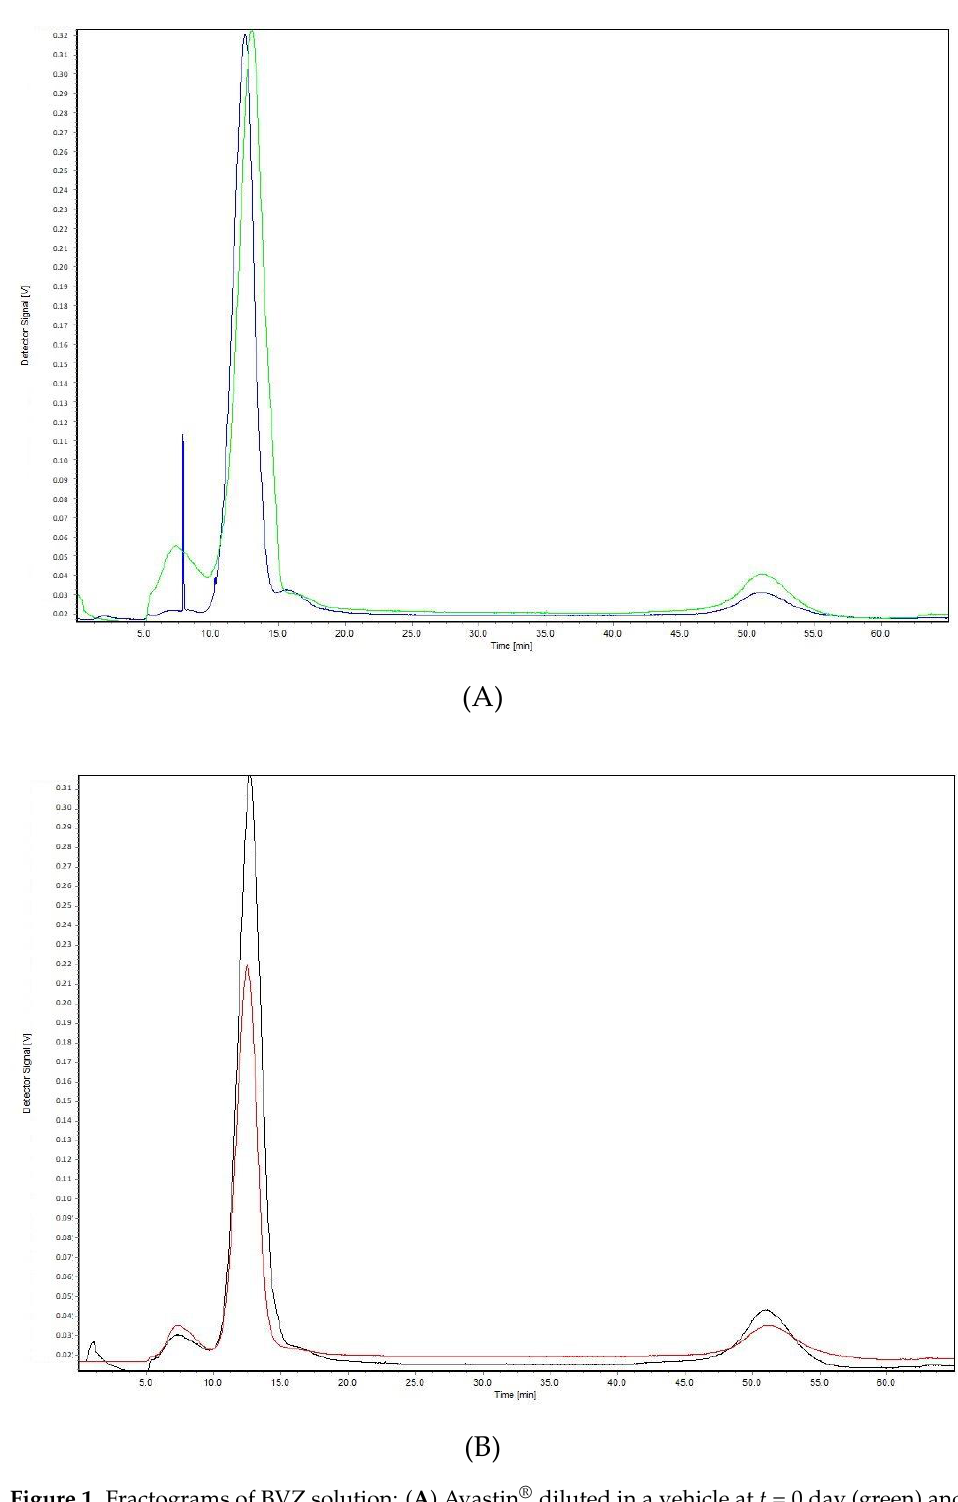
Figure 1. Fractograms of BVZ solution: ( A ) Avastin ® diluted in a vehicle at t = 0 day (green) and at t = 30 days (blue); ( B ) Avastin ® diluted in normal saline at t = 0 day (black) and at t = 30 days